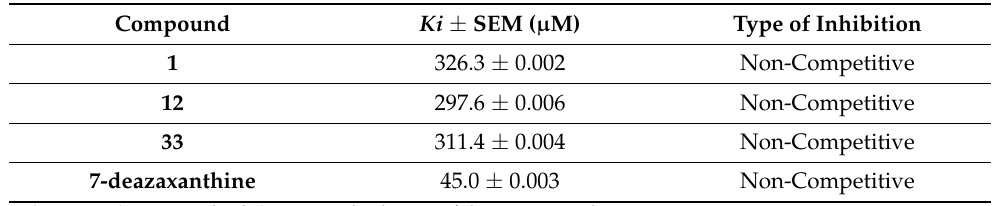
Table 2. Kinetics parameters of selected potent